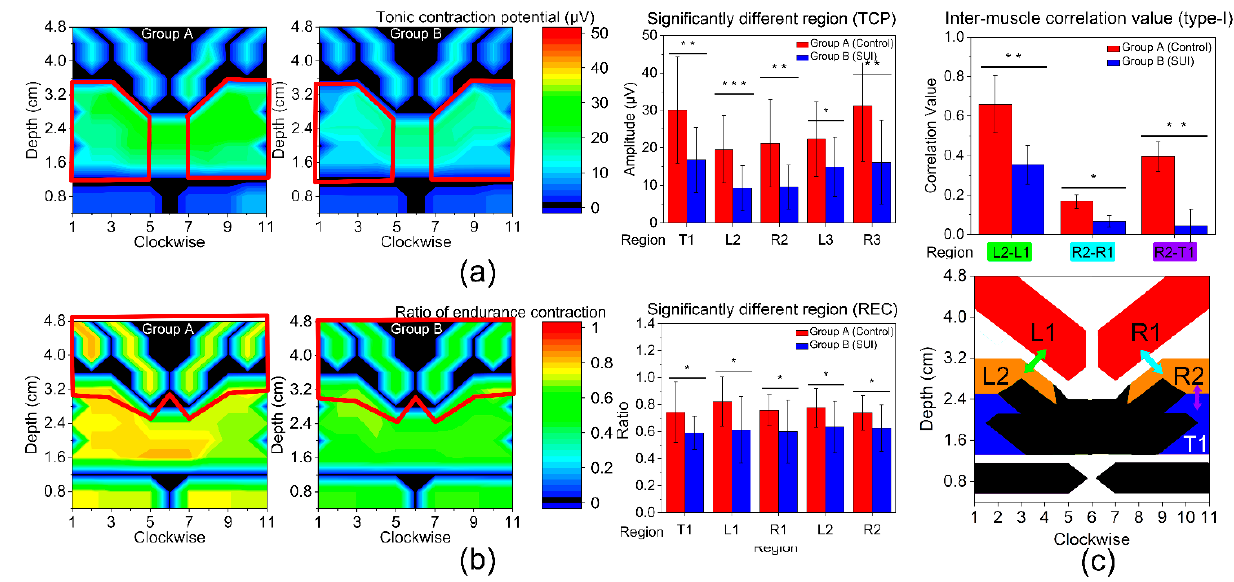
Figure 4. Type-I muscle function evaluation of two groups. ( a ) Tonic contraction potential (TCP) and ( b ) ratio of endurance contraction (REC) for each group. From left to right: amplitude results contour map of group A; amplitude results contour map of group B (red frame marks the significantly different regions); significantly different regions of parameter, including T1, L2, R2, L3, R3. According to the ultrasonic-assisted measurement, the muscle relationship corresponding to these regions are: T1: US; L2, R2: PC; L3, R3: PR. Asterisk indicates significant difference. *: p < 0.05; **: p < 0.01; ***: p < 0.001. ( c ) Inter-region correlation value of type-I muscle fiber. The upper graph is the significantly different region of correlation value and the lower is the location diagram.